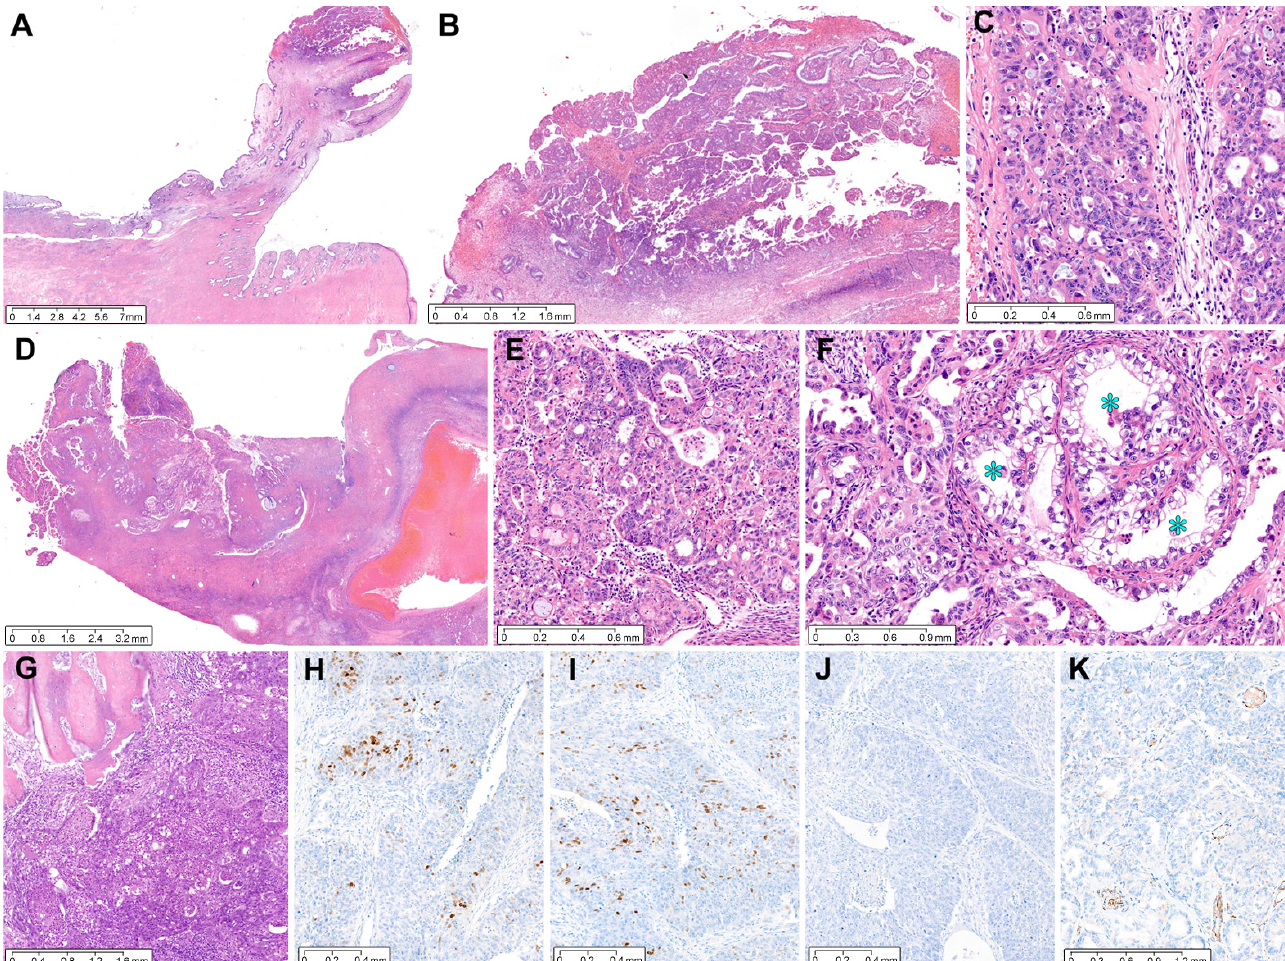
Figure 2. Grade 3 ovarian EC involving ECP: case 1. ( A ) A 1.7 cm pedunculated polyp arises from the endocervix. ( B ) Complex glandular proliferation involves the surface and stroma of ECP. The invasion depth measures 0.1 cm. ( C ) High-power magnification reveals poorly differentiated carcinoma displaying solid and cribriform architecture and high-grade cytological atypia. ( D ) The ovarian mass involves the surface and destructively invades the stroma. ( E ) The degree of cytological atypia and architecture are similar to those of poorly differentiated carcinoma involving ECP. ( F ) A few microscopic areas resembling clear cell carcinoma (blue asterisks) are noted in the ovarian tumor. ( G ) The sternal metastatic tumor invades the bony trabeculae and exhibits poorly differentiated carcinoma, and its histological features are similar to those of EC involving ECP (image ( C )) and ovary (image ( E )). ( H – J ) Immunohistochemical staining reveals focal and strong positivity for